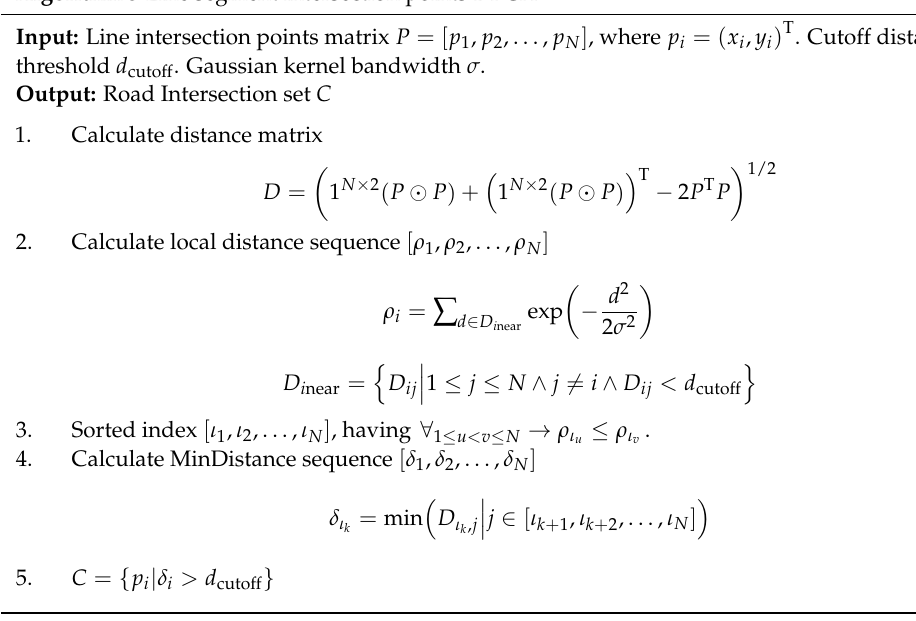
Algorithm 3 Line segment intersection points